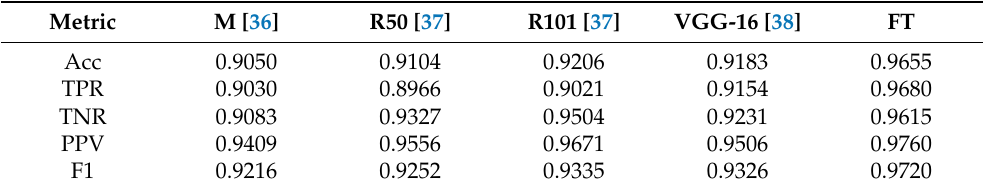
Table 5. Performance comparison on the Rabbani dataset. The proposed framework with ResNet101 [37] achieved comparable performance to the fine-tuned model.